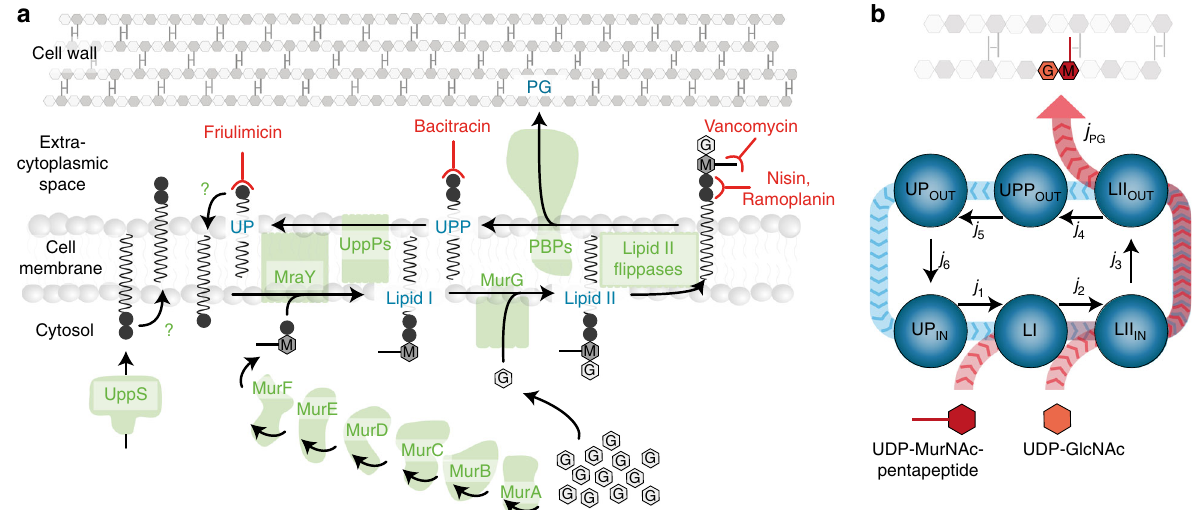
Fig. 1 The lipid II cycle of Gram-positive bacteria is a prime target for antibiotics. a The lipid II cycle, as the core pathway of cell wall biosynthesis, drives the transport of PG subunits across the cytoplasmic membrane via attachment to lipid carrier molecules. The cytoplasmic production of UDP-MurNAc- pentapeptide (M) from UDP-GlcNAc (G) is catalysed by the MurA-F ligases 34,75,76 . Subsequently, at the internal lea fl et of the cytoplasmic membrane the translocase MraY and the transferase MurG sequentially attach UDP-MurNAc-pentapeptide and UDP-GlcNAc to the lipid carrier undecaprenyl phosphate (UP), giving rise to the lipid I and lipid II intermediates, respectively. Various fl ippases translocate lipid II to the outer lea fl et of the cytoplasmic membrane, where penicillin-binding proteins (PBPs) incorporate the subunits into the growing PG layer. This leaves the lipid carrier in its pyrophosphate form (UPP), which has to be recycled to UP by dephosphorylation to allow a new round of PG monomer transport. Given that all known UPP phosphatases (UppPs) act at the external lea fl et of the cytoplasmic membrane 77,78 , carrier recycling requires fl ipping of UP to the internal lea fl et by a yet unknown mechanism 68,69 . Finally, dilution of lipid carriers is counterbalanced by cytoplasmic synthesis of UPP by UppS, but likewise to UP fl ipping, the required mechanism to present UPP to the externally acting phosphatases is unknown. Several antibiotics inhibit key steps of cell wall biosynthesis by forming complexes with UP, UPP or lipid II, as indicated by the T-shaped red lines. b The lipid II cycle can be considered as a closed-loop system, in which all fl uxes j i from one state of the cycle into the next balance each other. Since UDP-MurNAc-pentapeptide and UDP-GlcNAc use lipid II cycle intermediates as carriers for the transport across the cytoplasmic membrane, the fl ux of PG precursors, j PG (red arrows), is equal to the fl ux of the cycling reactions (blue